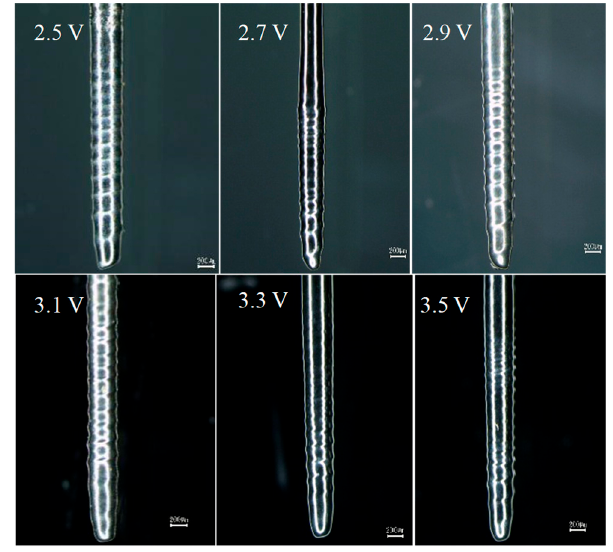
Figure 8. The spiral cylindrical microelectrodes fabricated under different machining voltages.